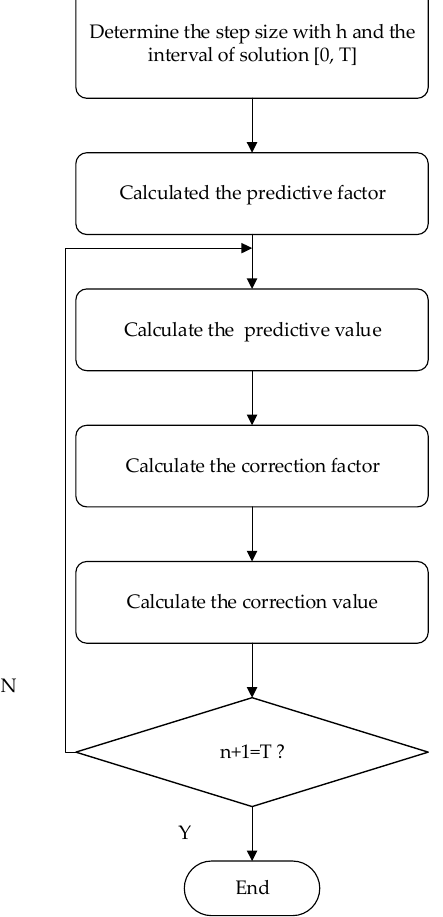
Figure 5. The flow of numerical calculation of the Adams prediction–correction method.